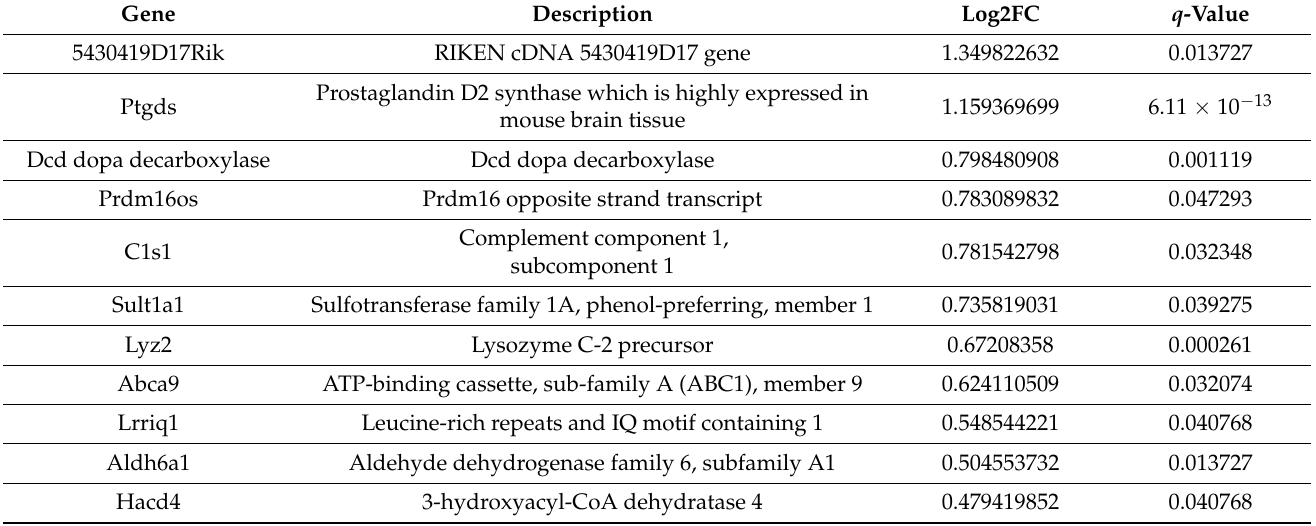
Table A3. The 19 DEGs unique to the comparison of Mock samples at 4 dpi vs. 2 dpi. Gene